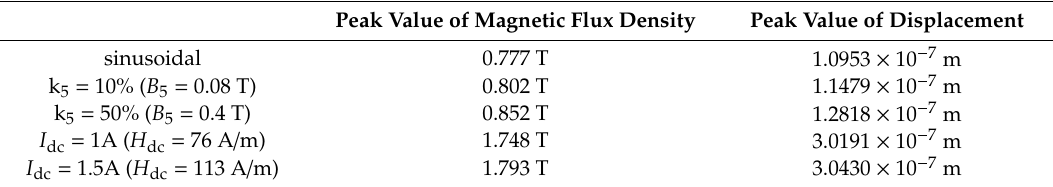
Table 1. Peak values of magnetic flux density and displacement on point A in a period under di ff erent magnetizations ( B 1 = 0.8 T).